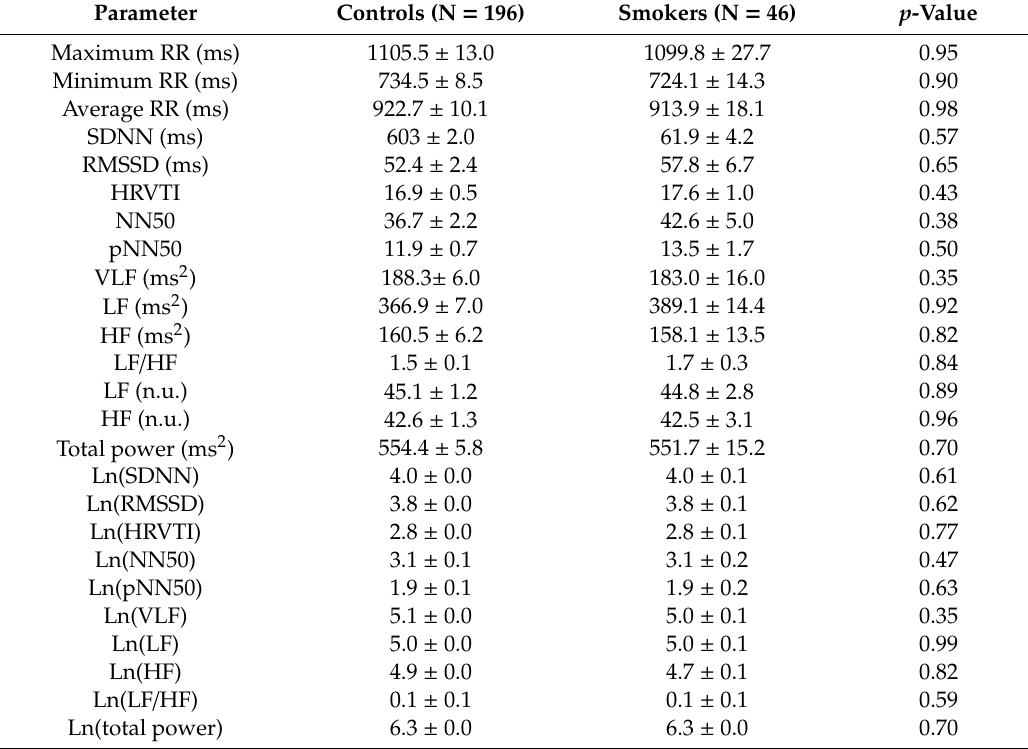
Table 2. Values of HRV parameters in smokers and